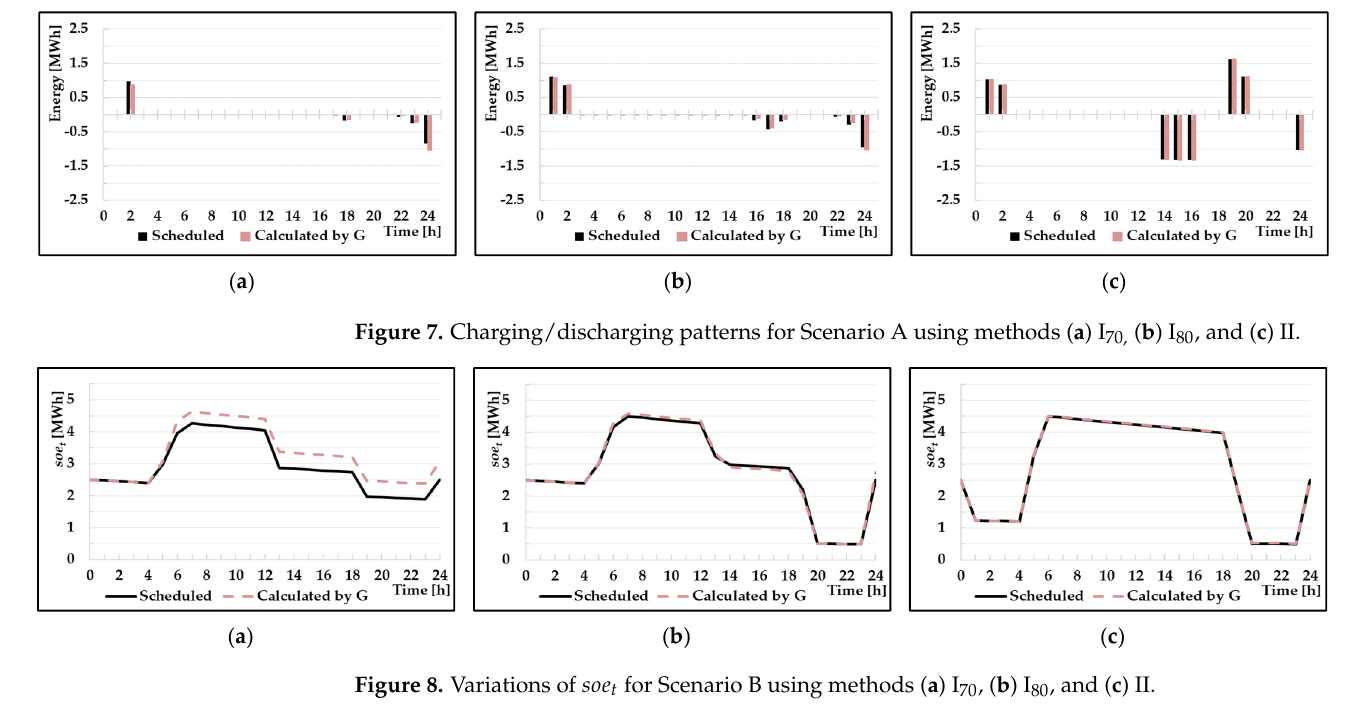
Figure 9. Charging/discharging patterns for Scenario B using methods ( a ) I 70 , ( b ) I 80 , and ( c ) II. In Scenario C, both Cases I 70 –C and I 80 –C, in which method I was used, were outside the specified operating range. Because the efficiencies of 70% and 80% applied to Method I are intermediate values of the nonlinear efficiency curve, errors may occur in both the upper and lower limits of the